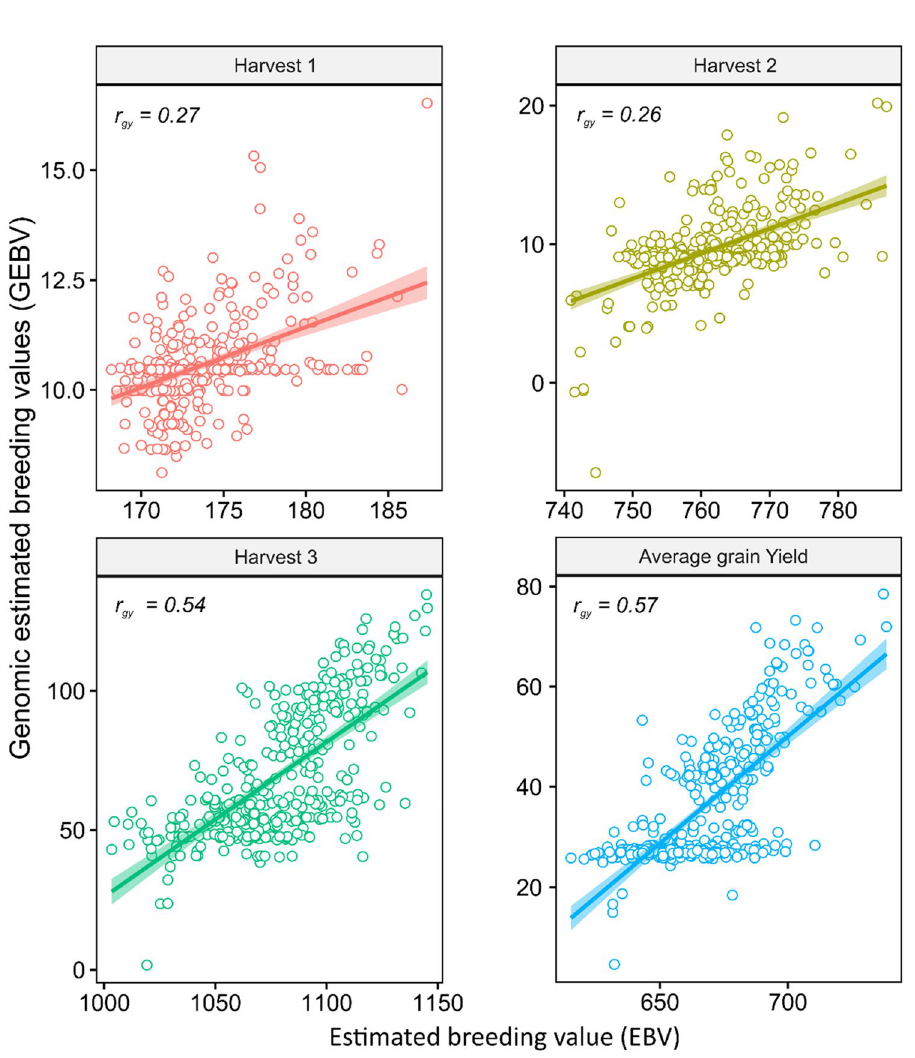
Figure 1. Scatterplots of genomic estimated breeding values (GEBVs) by RR-BLUP and unregressed phenotypes observed for grain yield. r gy : predictive ability of genomic selection. The package used of R to create this Figure was ggplot2 (v0.3.3, https:// cran.r- proje ct. org/ web/ packa ges/ ggplo t2/ index.